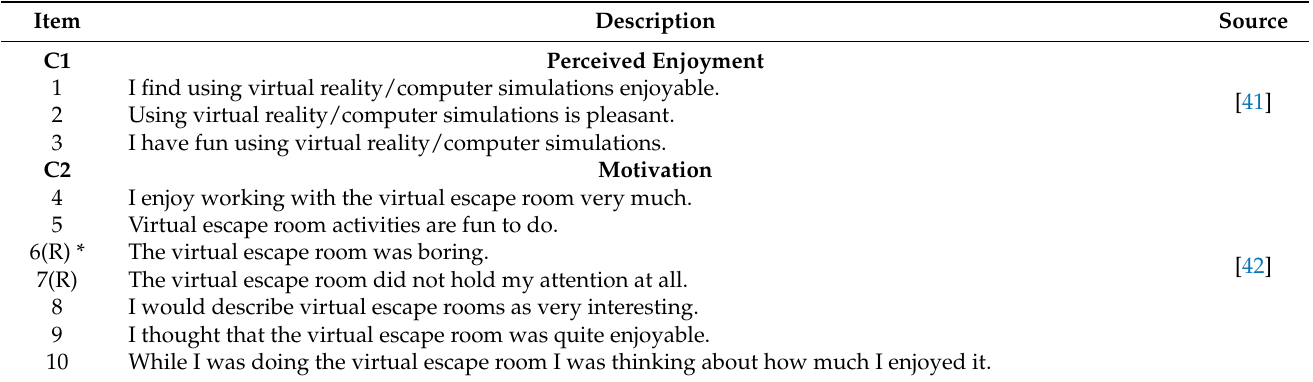
Table A1. Questionnaire items regarding participants’